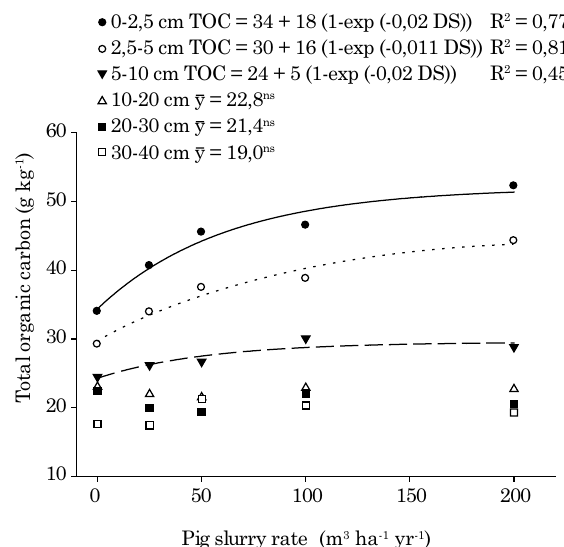
Figure 1. relation between total organic carbon (tOC) contents and pig slurry (Ps) rates (unfertilized treatment - 0; treatment with 25, 50, 100 and 200 m 3 ha -1 yr -1 ) applied annually in soil layers (0.0-2.5, 2.5-5.0, 5-10, 10-20, 20-30, and 30-40 cm) of a typic Hapludox under no-tillage (nt) maize and black oat in the mean of four replications. *: significant at 5 %, ns : not